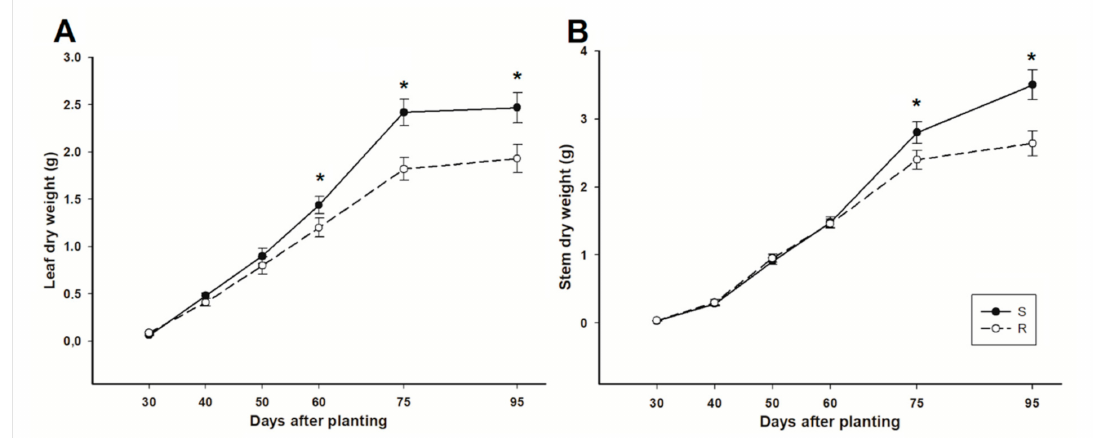
Figure 3. Leaf ( A ) and stem ( B ) dry weight of imazamox-resistant (R) and susceptible (S) wild poinsettia plants. * indicates significant di ff erences at p < 0.05. Vertical bars ± standard error ( n =